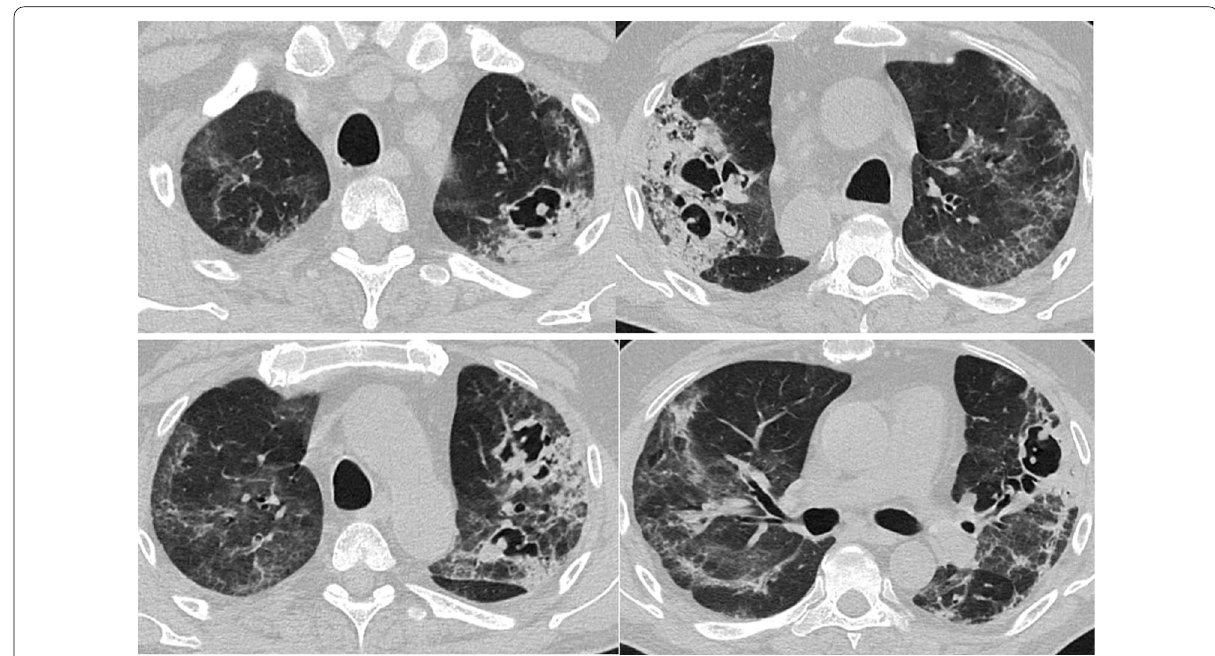
Fig. 6 Axial HRCT images of case 6 shows multiple cavitary lesions in both lungs with irregularly margined soft tissue attenuation nodular growth. Sputum culture revealed Candida